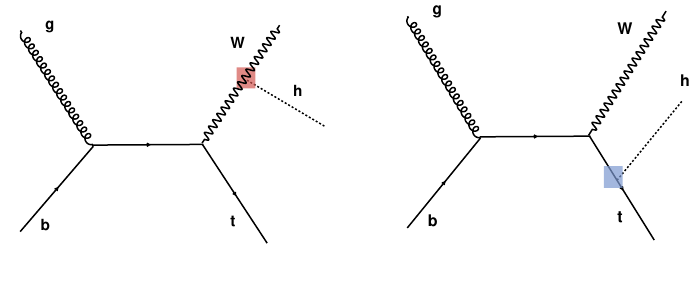
Figure 4 . Feynman diagrams contributing to thX production with X = W